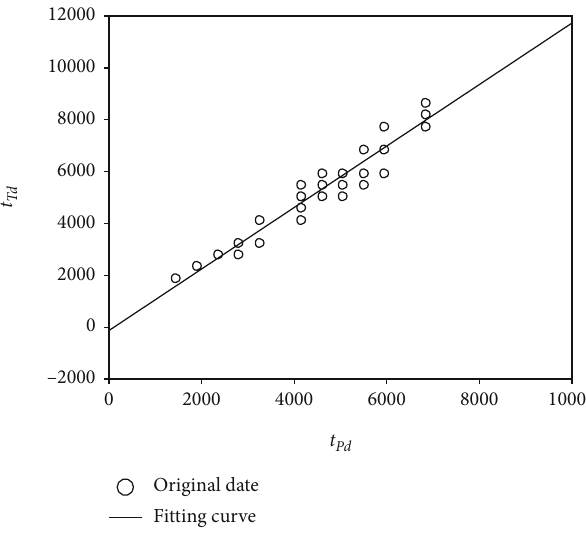
Figure 11: Linear fi tting of data.